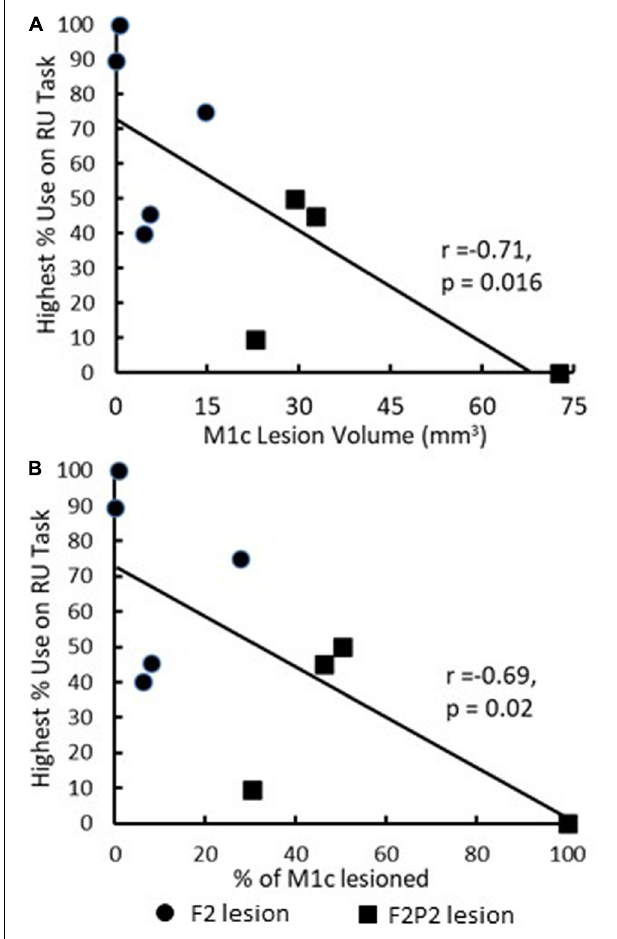
FIGURE 8 | Scattergraphs showing the relationship between highest %use of the contralesional hand in a single RU test with M1c lesion volume (A) and percentage damage to M1c arm/hand area (B) . Each plotted point is data for a single monkey. All nine monkeys were included in this figure and correlation